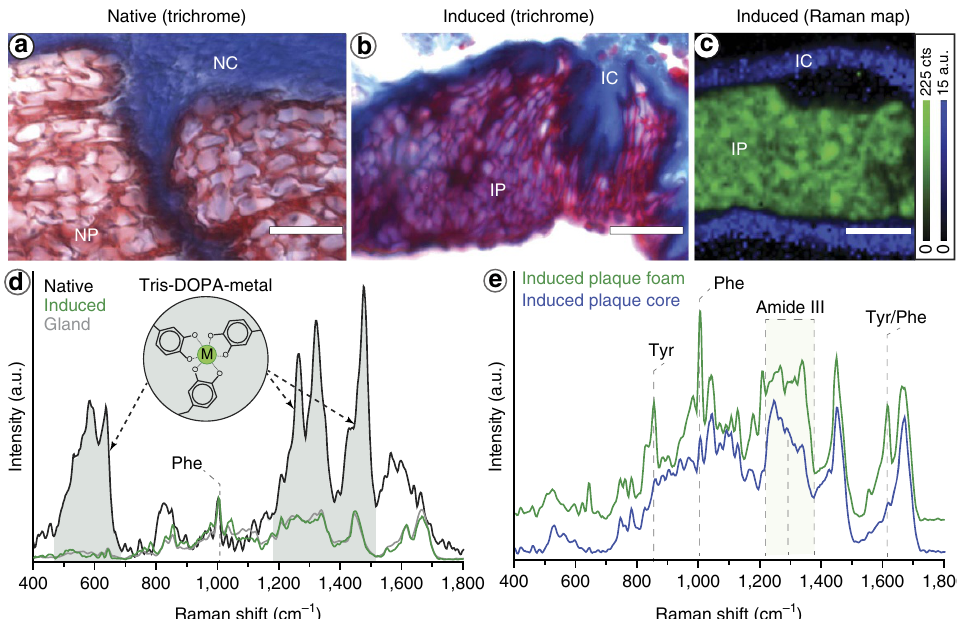
Figure 7 | Histological and Raman characterization of induced thread plaque. ( a ) Trichrome-stained native plaque showing the interface between native plaque foam (NP) and native core fibres (NC). ( b ) Trichrome-stained induced plaque showing the interface between induced plaque foam (IP) and induced core fibres (IC). Native and induced plaques show a very similar microscale structure. ( c ) Raman confocal spectroscopic image of an induced plaque integrated over two spectral regions corresponding to the induced plaque foam (green; 1,600–1,630cm (cid:2) 1 ) and the induced core fibres (Blue; ratio of integration of 1,200–1,292 to 1,292–1,377cm (cid:2) 1 ). Clear separation of the core and plaque proteins is observed, confirming that precursors are stored and assemble as a dense immiscible phase. ( d ) Comparison of Raman spectra from native plaque, induced plaque and plaque gland. The intensities of the three spectra are normalized to the Phe peak height at 1,006cm (cid:2) 1 , emphasizing the much larger intensity of the DOPA resonance Raman peaks. ( e ) Raman spectra extracted from the plaque foam and core fibre regions from panel c . Scale bars are 10 m m for panels a – c